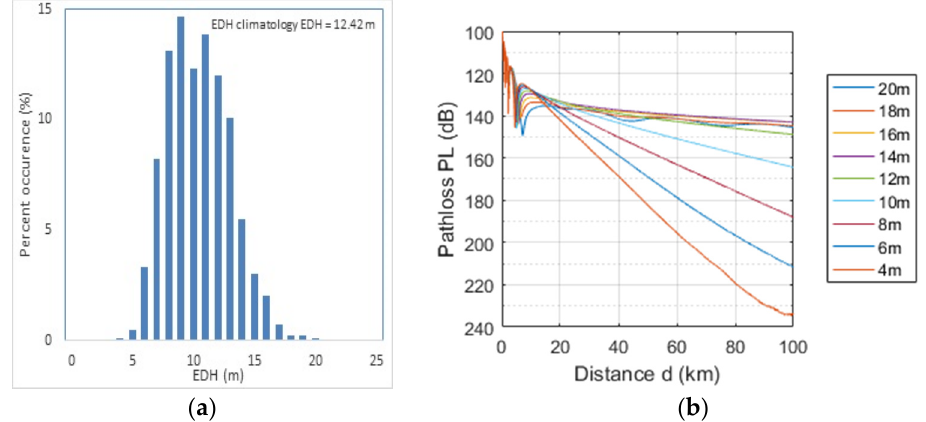
Figure 4. ( a ). Annual average evaporation duct height EDH variations and percentage of occurrence in the South China Sea [15] ( b ). Path loss in dB for varying distance due to EDH variations causing additional slow fading.